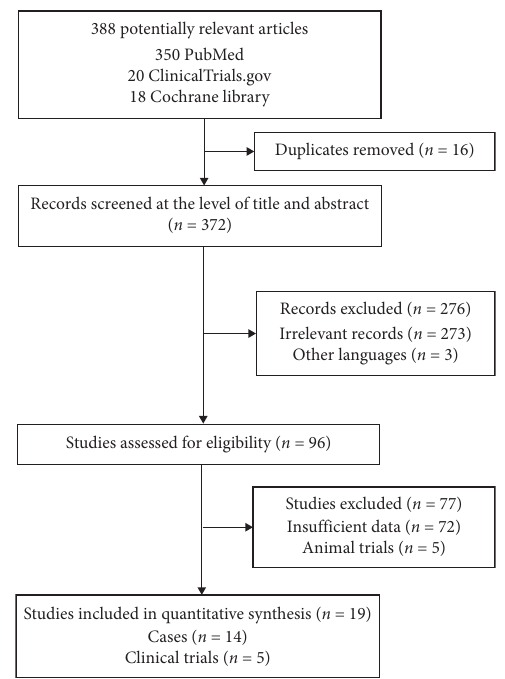
Figure 1: Flowchart for study